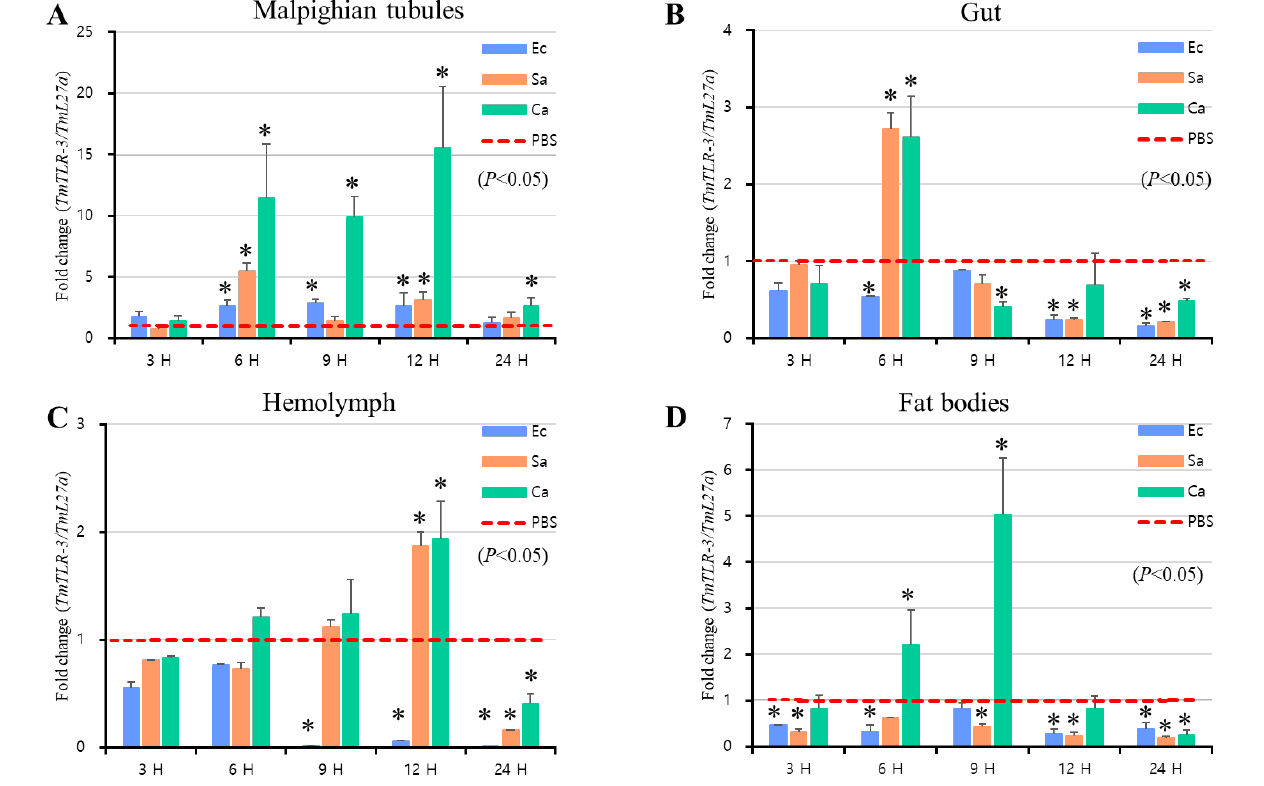
Figure 3. mRNA expression patterns of TmToll-3 in immune-challenged T. molitor larvae. mRNA levels of TmToll-3 in the Malpighian tubules ( A ), gut ( B ), hemolymph ( C ), and fat bodies ( D ) were examined by qRT-PCR 3, 6, 9, 12, and 24 h after infection with E. coli (10 6 cells/µL), S. aureus (10 6 cells/µL), and C. albicans (5 × 10 4 cells/µL). TmToll-3 mRNA expression was upregulated in response to all infectious sources and exhibited tissue- and time-dependent variations. The highest TmToll-3 expression level was observed in the Malpighian tubules in response to C. albicans challenge. PBS was used as an injection control and T. molitor 60S ribosomal protein 27a ( TmL27a ) primers were used as an internal control to quantify relative gene expression ( n = 3). The asterisks indicate significant differences between infected and PBS-injected larval groups as determined using Student’s t -test ( p < 0.05). The vertical bars indicate means ± SD for each experimental condition ( n =